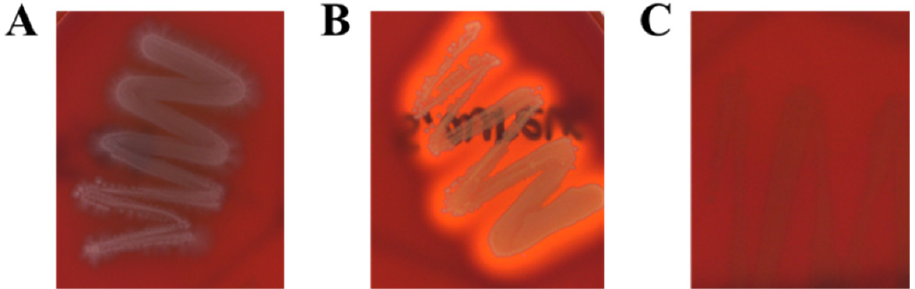
Figure 2. Hemolytic activities of L. fermentum KGC1601, Escherichia coli KCTC2441 , and Staphylococcus aureus NCTC10788 . E. coli were shown typical α -hemolysis ( A ) and S. aureus was shown typical β -hemolysis ( B ). However, L. fermentum KGC1601 ( C ) did not show any lysis of the blood cells.